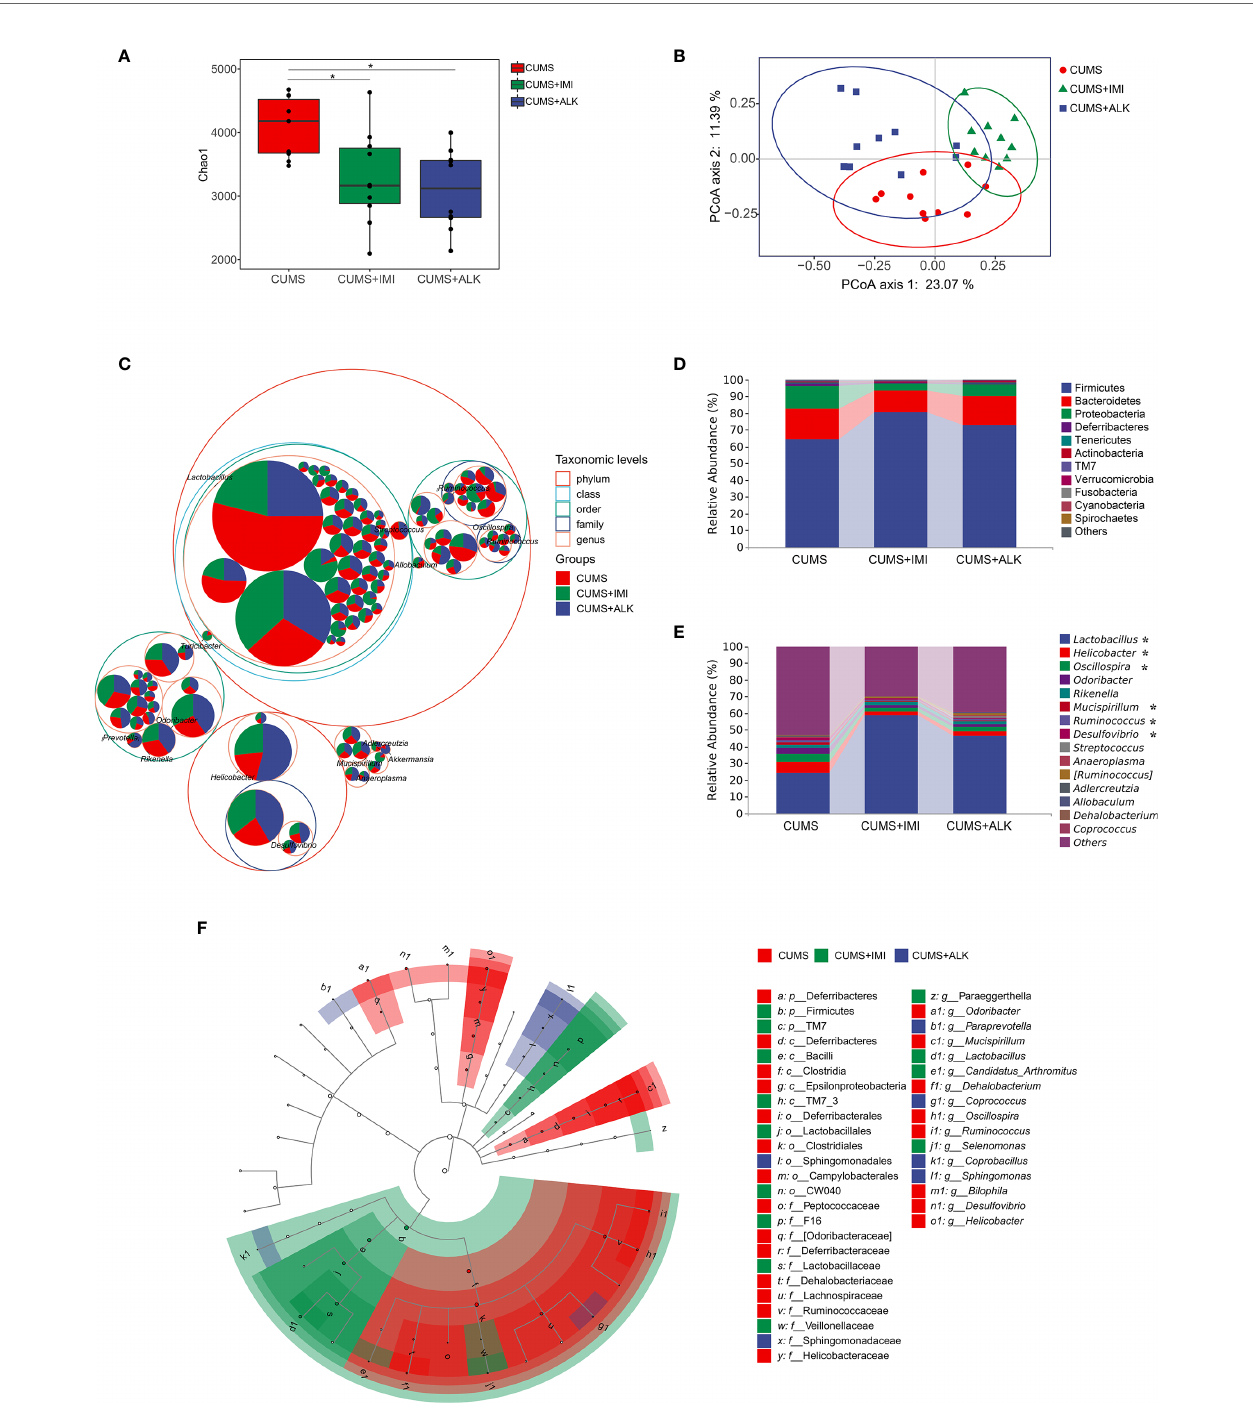
FIGURE 4 | Diversity variation and differential abundance in the gut microbiota composition of mice in different treatment groups. (A) The Chao1 index of different treatment groups. Data are presented as the mean ± SE. Mann-Whitney U test results are shown at the top of each paired comparison. * P < 0.05 versus the CUMS group. (B) PCoA based on the Bray-Curtis distance for gut microbiota (PCo1 vs. PCo2). Ellipses indicate 95% con fi dence intervals (CIs). (C) Taxonomic tree in packed circles. The largest circles represent the phylum level, and the inner circles represent class, order, family, and genus. The pie chart shows the proportion of each ASV in the different treatment groups. (D) Stacked bar chart of the most abundant phyla for CUMS, CUMS+IMI and CUMS+ALK mice. (E) Stacked bar chart of the mean relative abundances of bacterial taxa at the genus level for CUMS, CUMS+IMI and CUMS+ALK mice. Asterisks represent microbial taxa with signi fi cant differences. (F) Cladogram of ASVs with LDA scores greater than 2 based on LEfSe. Different colors represent different groups. Letters represent the position of ASVs in the